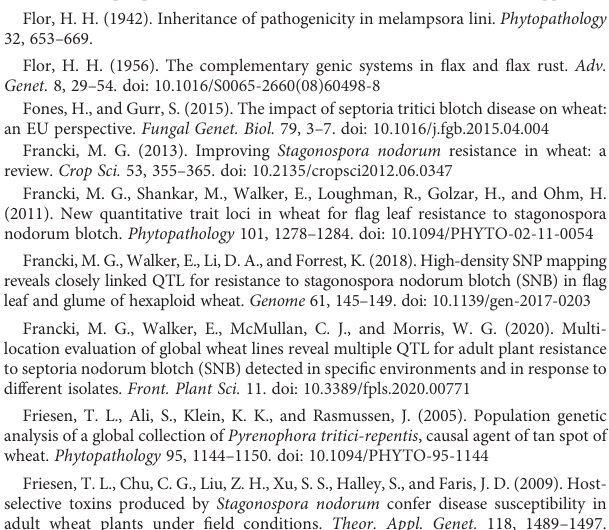
Figueroa,M.,Hammond-Kosack,K.E.,andSolomon,P.S.(2018).Areviewofwheat diseases: a fi eld perspective. Mol. Plant Pathol. 19, 1523 – 1536. doi: